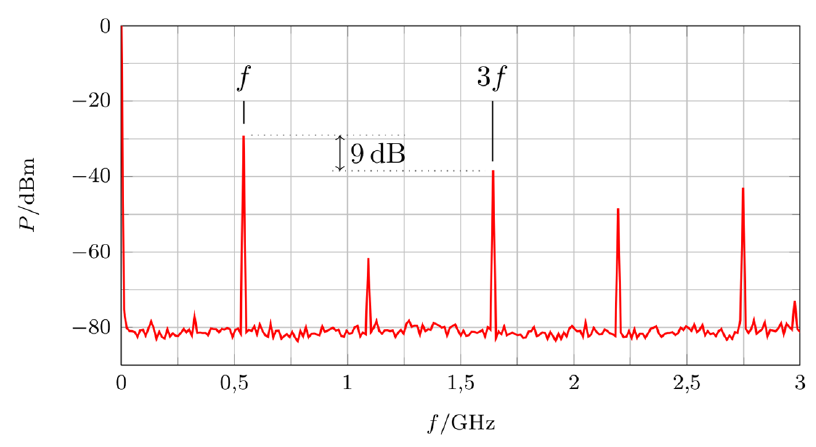
Figure 6. Measured spectrum for single tone